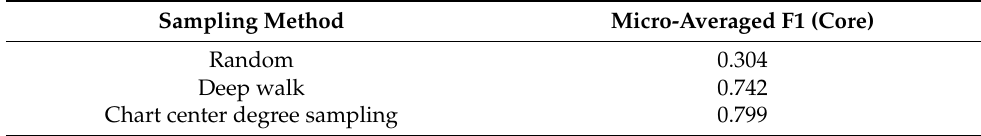
Table 3. Comparison of sampling results (micro-averaged